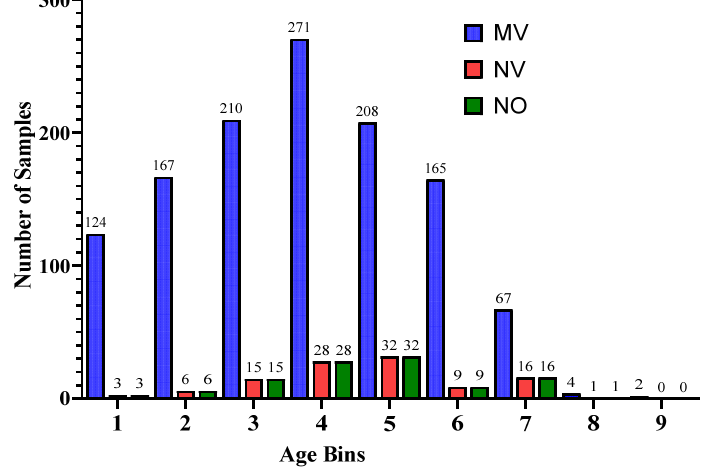
Figure 2. Distribution of patient age range according to ventilator support cases.